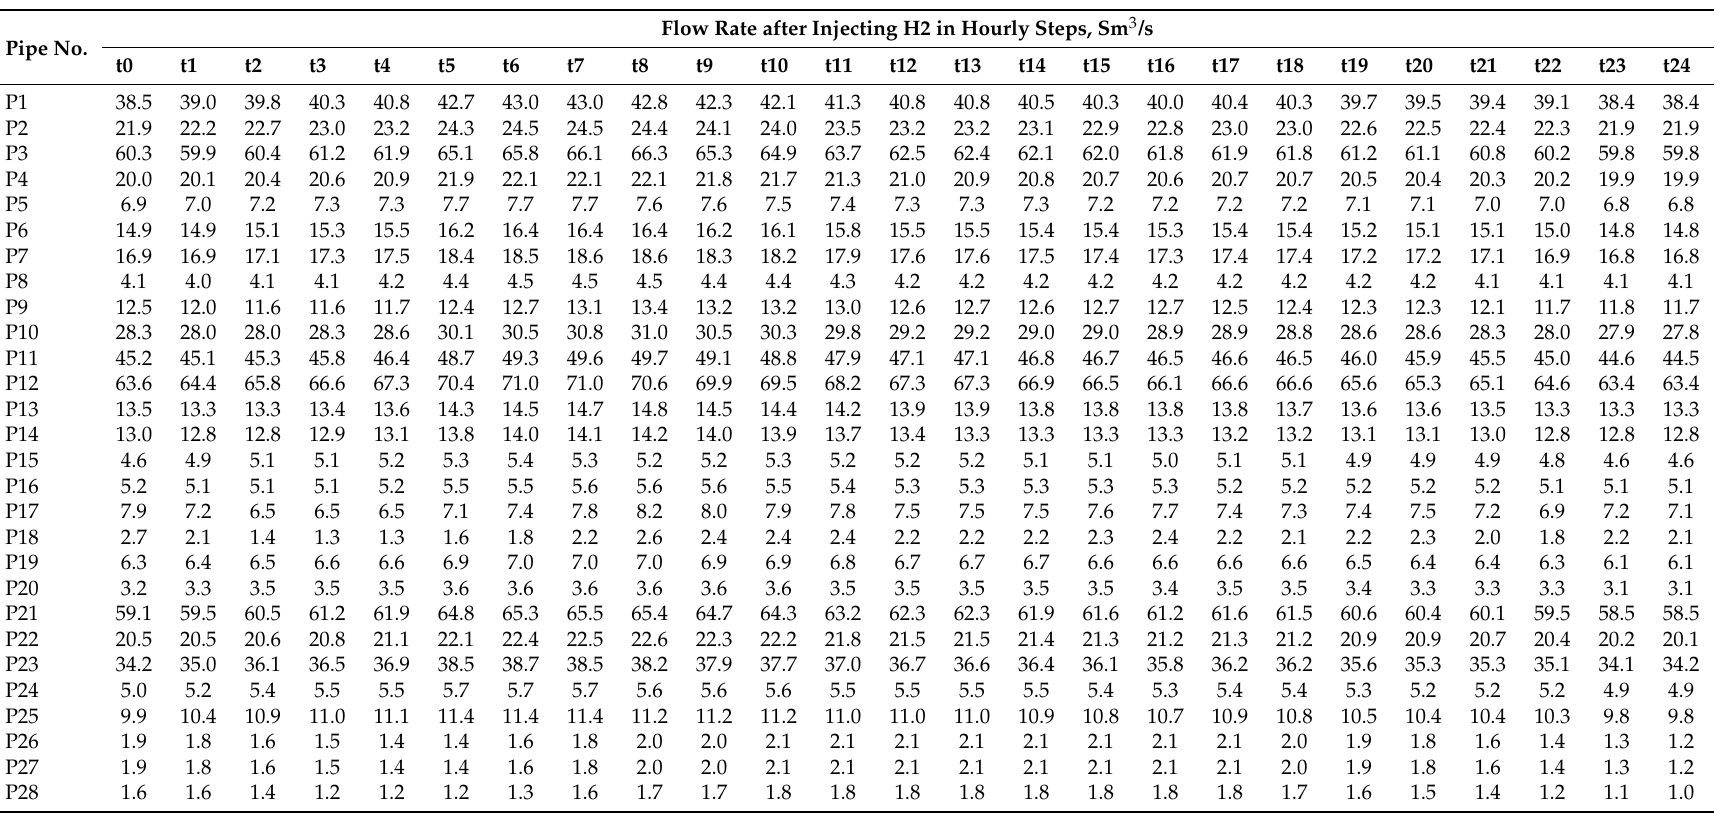
Table A4. Flow rate after injecting H2 in hourly